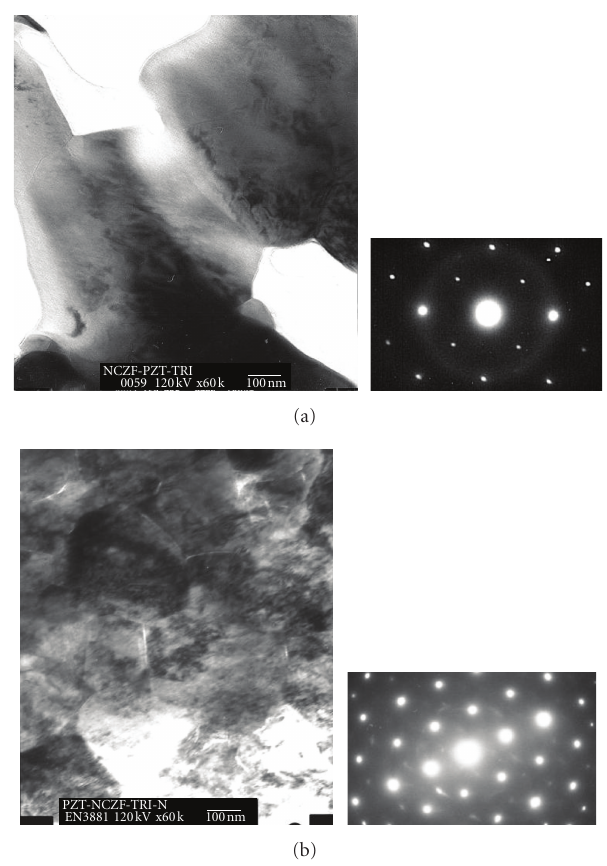
Figure 22: TEM micrograph and SAED pattern for (a) PZT-PZN and (b) NCZF near the